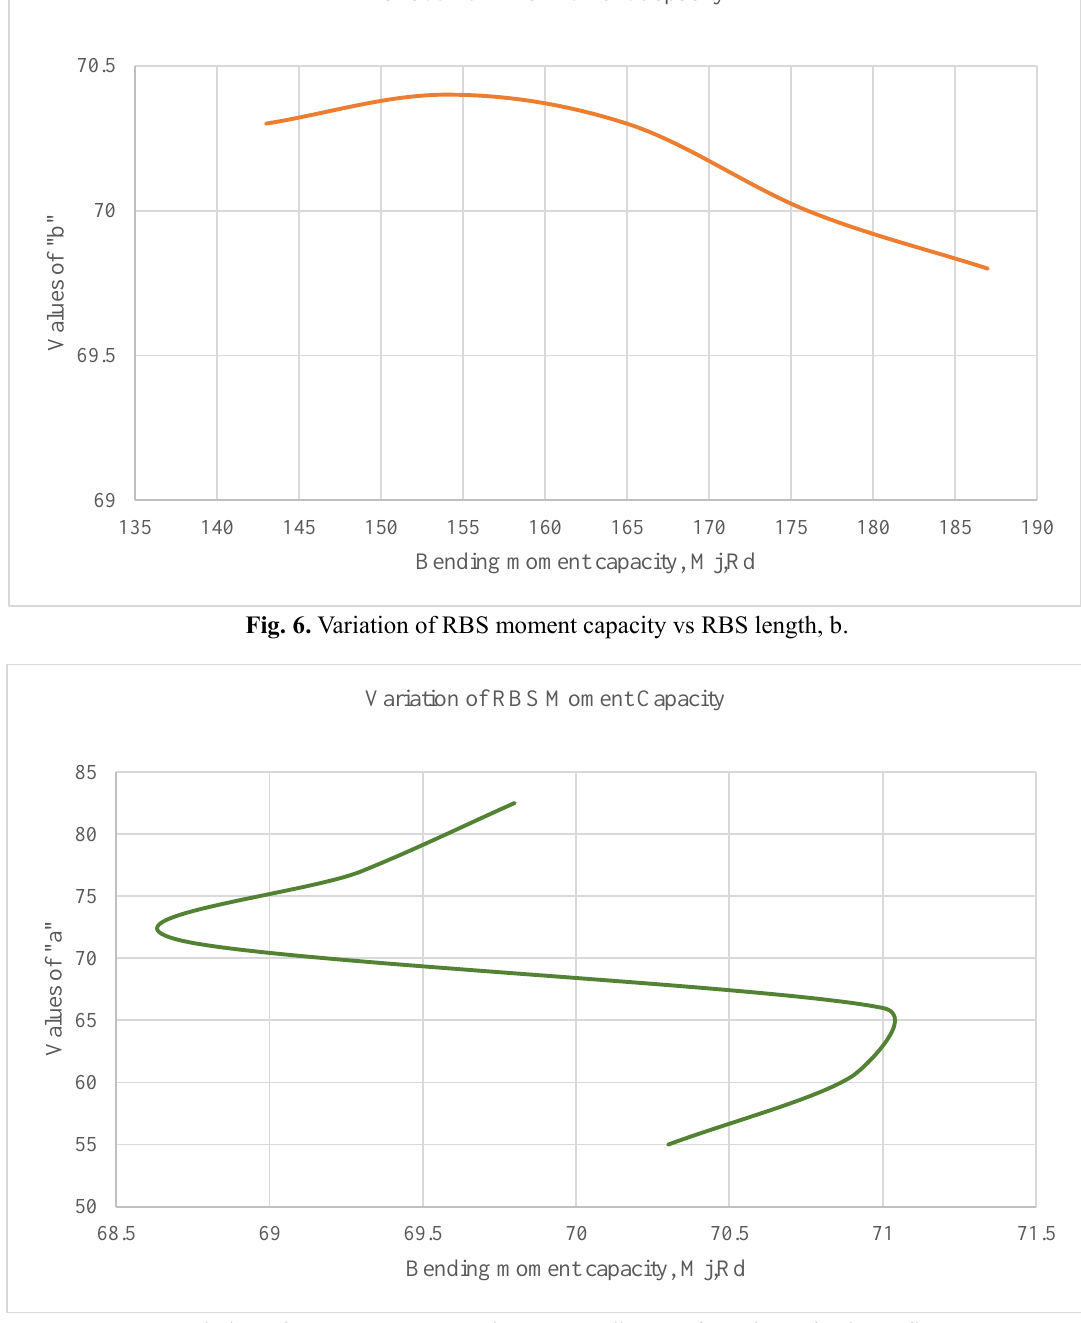
Fig. 7. Variation of RBS moment capacity vs RBS distance from face of column flange,